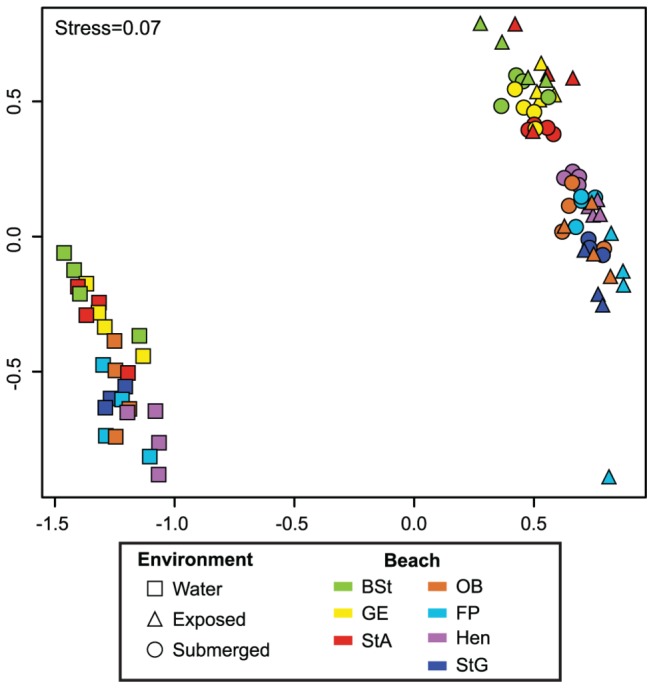
Non-metric multidimensional scaling (NMDS) plot of bacterial community composition among all sand and water samples.The NMDS is based on OTU community similarity (Morisita-Horn) among samples from all exposed and submerged sand and water samples. The average OTU composition for all beaches with multiple sequenced samples from the same date is represented by a single sample point.